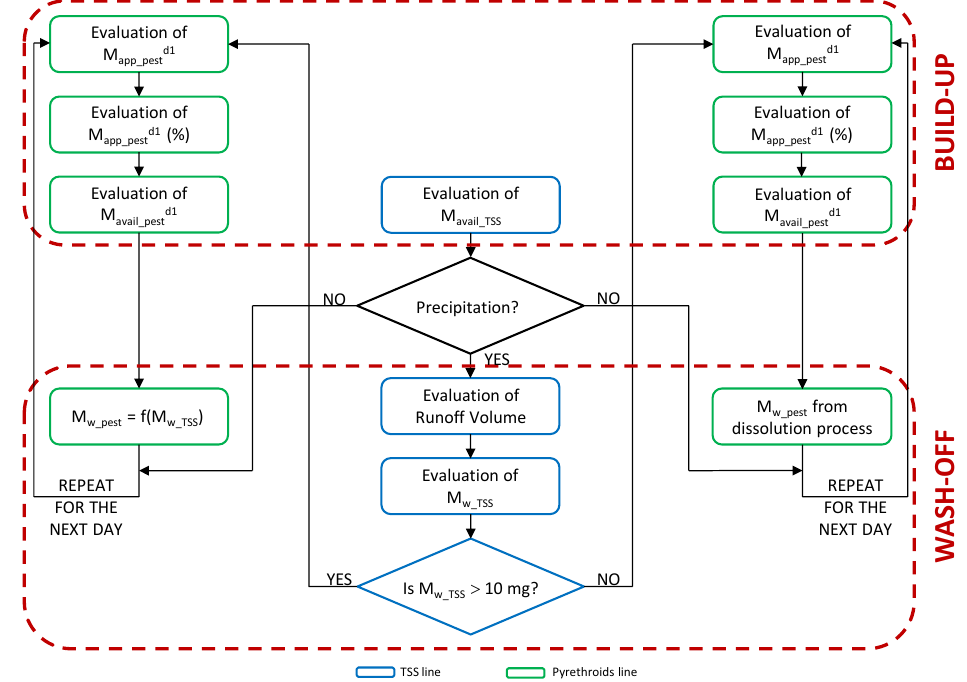
Figure 7. Flow chart of the new physically based stormwater quality model (d1 = “day one”).